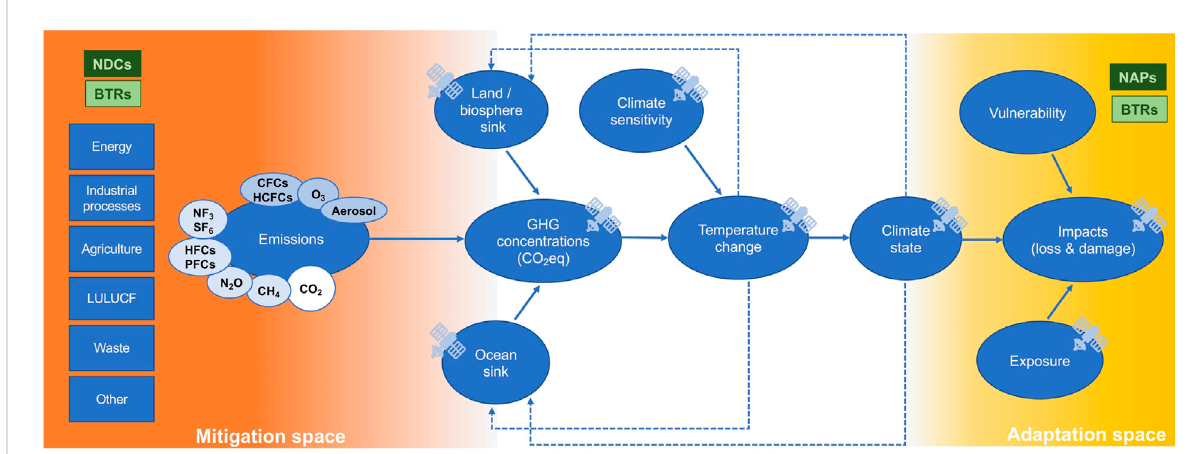
FIGURE 4 Cause-effect network depicting different pathways and Earth system feedbacks that need to be considered when trying to quantify how GHG emissions from different sectors (mitigation space) determine the climate state and thus climate impacts (adaptation space). Ozone and aerosol are generatedfromprimaryemissionsofarangeofshorter-livedtracegasesthat,alongwithCFCsandHCFCs(whicharecontrolledundertheMontreal Protocol),arenotincludedundertheParisAgreement.However,theyaffecttheEarth ’ sradiativeforcingandthusneedtobeknowntocorrectly attributetemperaturechanges.BothmitigationandadaptationspaceshaveblurredboundariesinthecontextoftheEarthsystembecauseofoptions to alter the natural environment to deal with climate change (e.g., reforestation, ocean fertilisation, urban greening). The satellite icons indicate where EO offers useful information and constraints on the Earth system and its